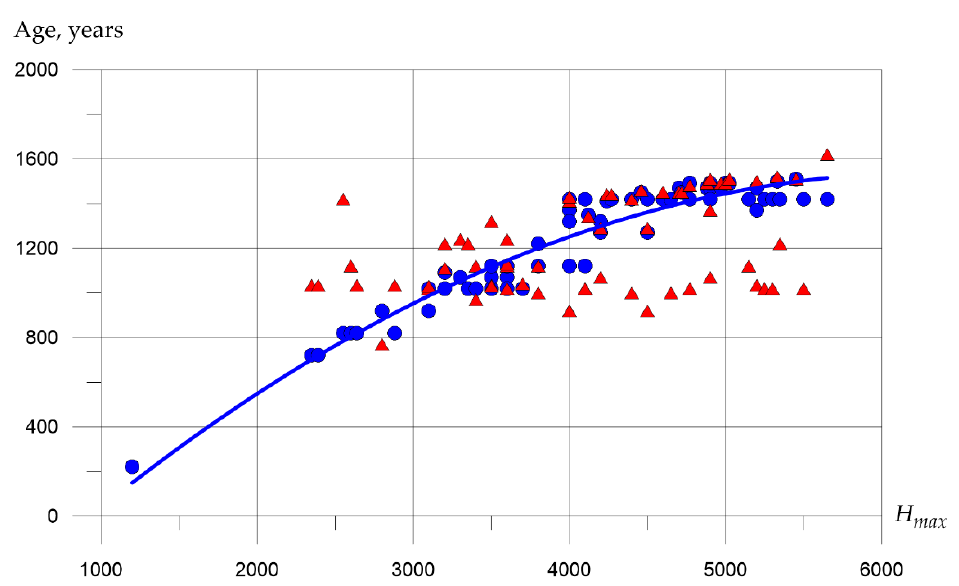
Figure 15. Dependence of the object’s age on absolute intensity of the calcite most intense peak H max . Blue—predicted values according to the authors’ method. Red—age of objects from archaeological data.